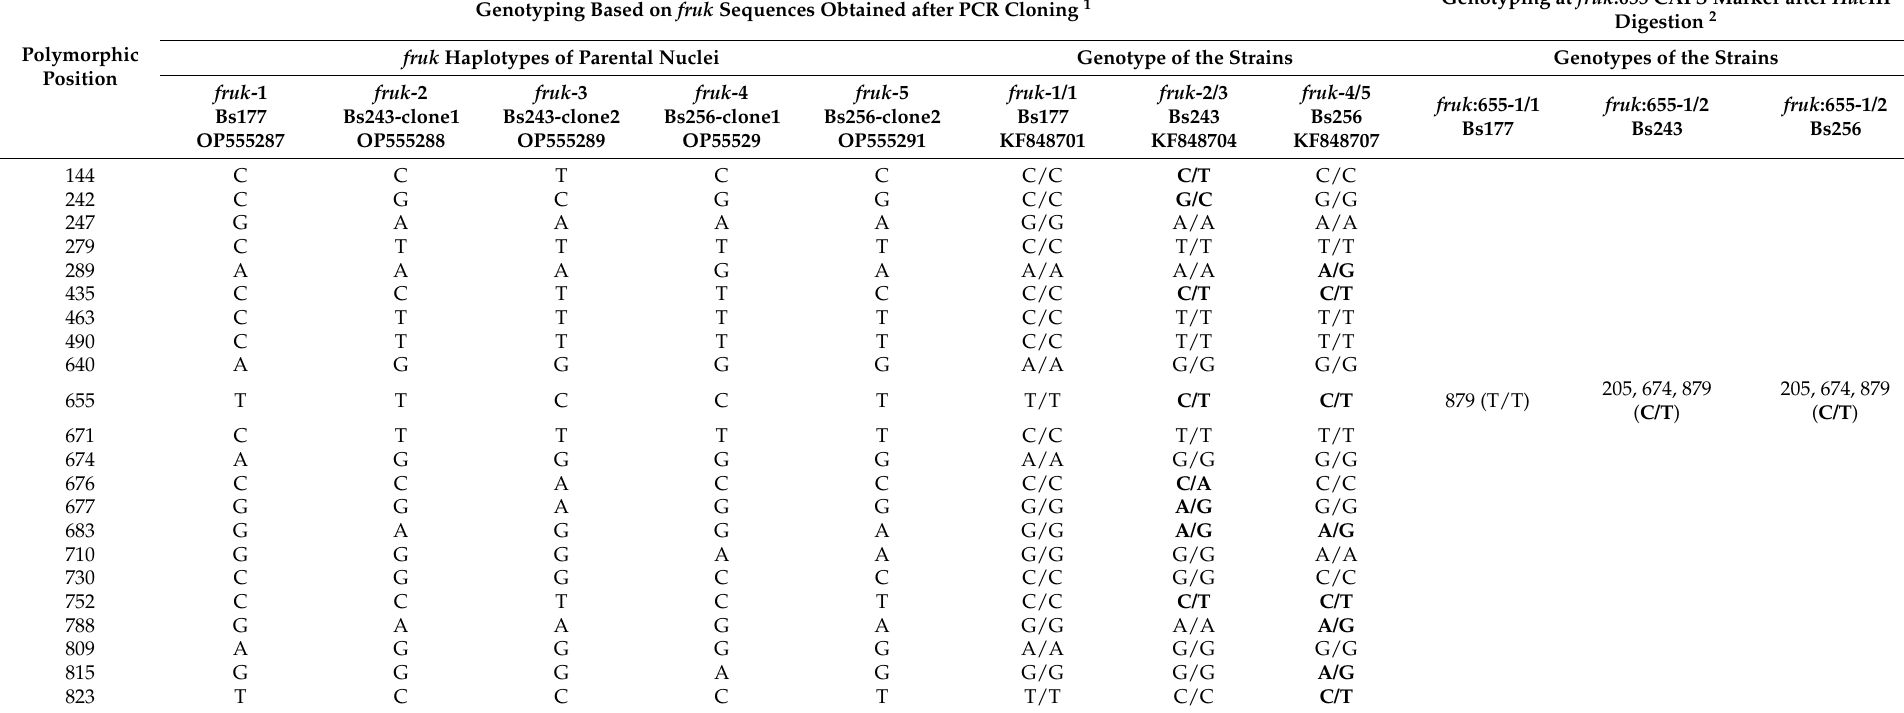
Table 2. Genotyping of three wild strains, either using fruk haplotypes or using the CAPS marker fruk655.